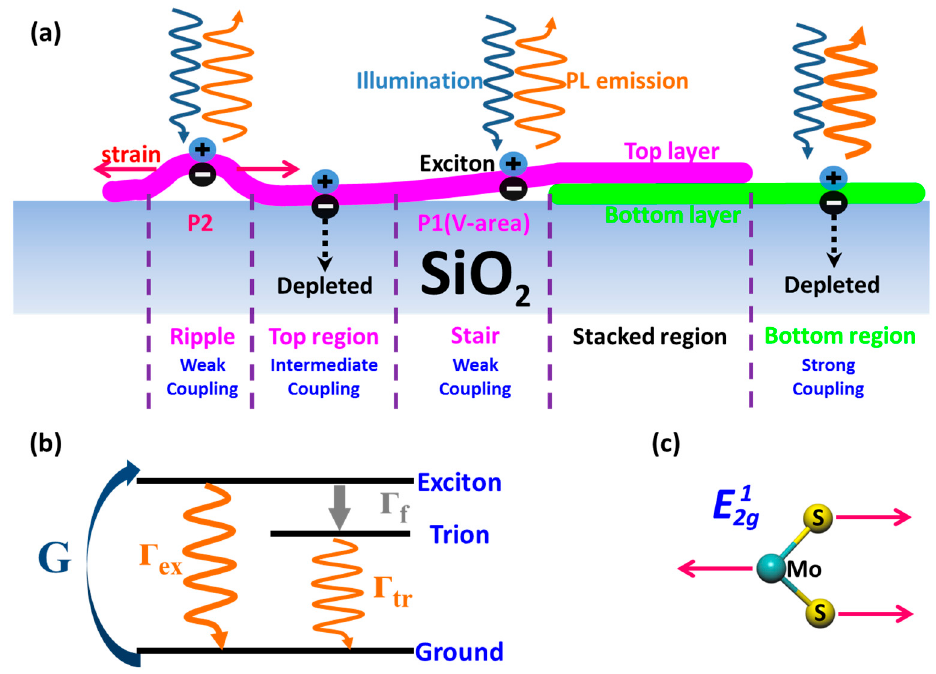
Figure 5. Schematic illustration. ( a ) Film–substrate coupling difference among bilayer-stacked two-dimensional materials structure (BSS) films. ( b ) Three-level energy diagram including exciton, trion, and ground. G represents the generation rate of exciton. Γ ex , Γ f , and Γ tr represent exciton decay rate without trion formation rate, trion formation rate, and trion decay rate, respectively. ( c ) Schematic of in-plane Raman mode E 1 for monolayer MoS 2 .